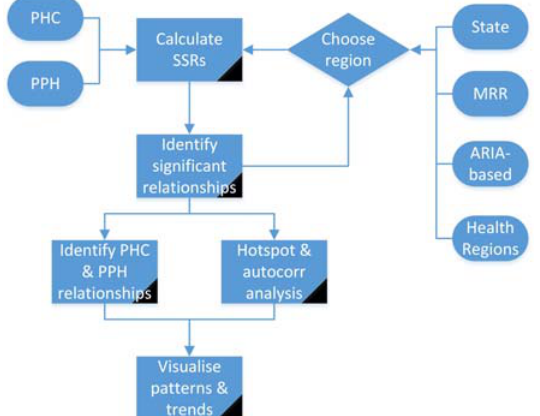
Figure 1. Methodology for exploring geospatial variation in diabetes health